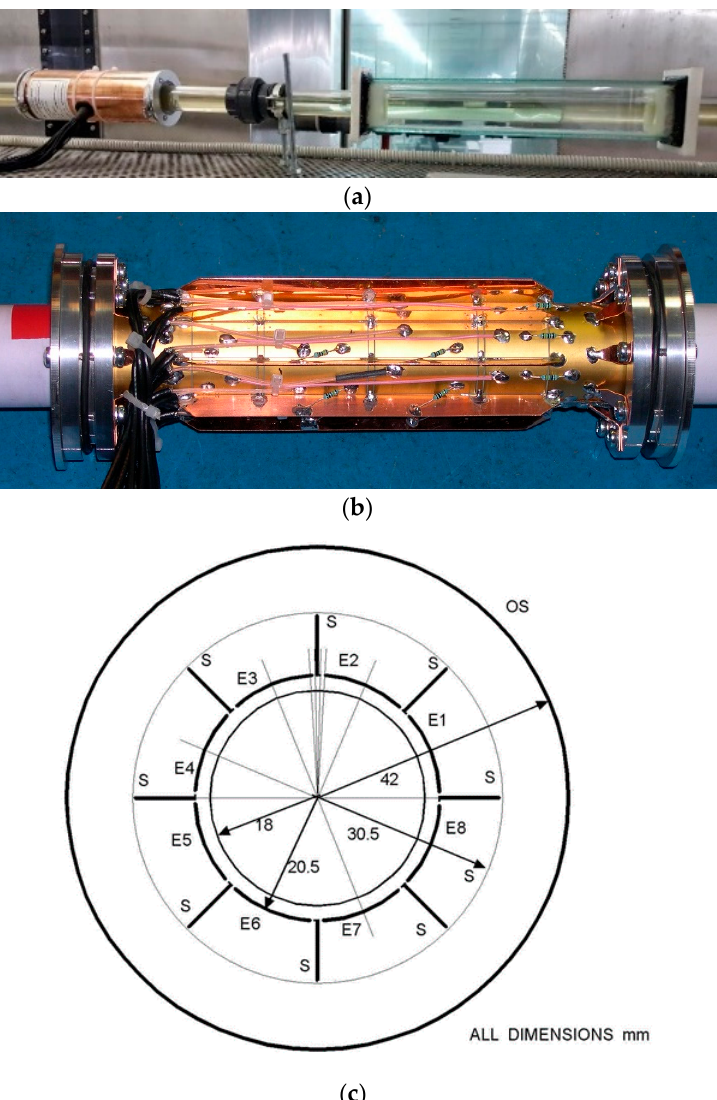
Figure 2. Photographic view ( a ) the transparent rectangular box and ECT sensor, ( b ) ECT equipment used in the experiments, and ( c ) schematic illustration of the ECT sensor cross-section.